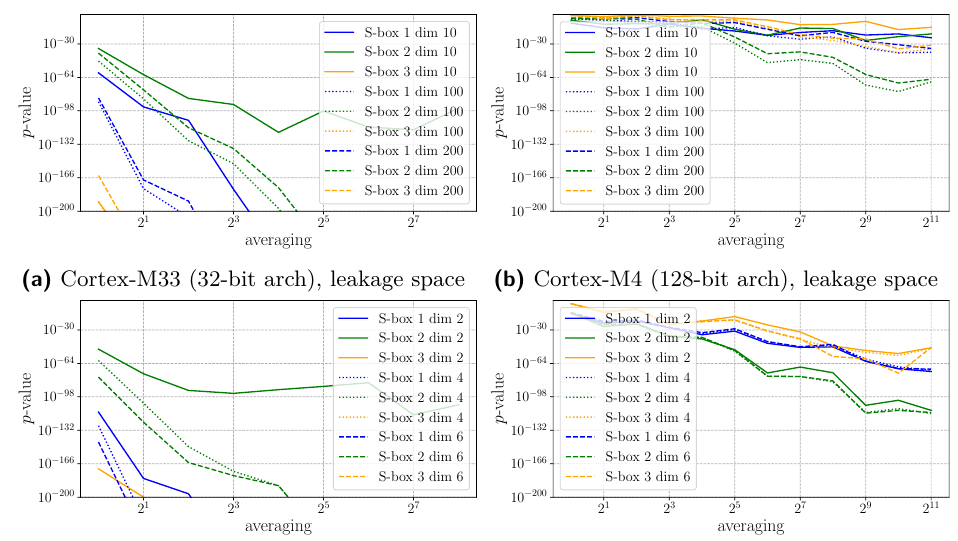
Figure 5: Hotelling’s T 2 -test between leakage distributions of S-box 0 and other S-boxes for various number of dimensions, computed with (averaged) 2 , 000 samples per